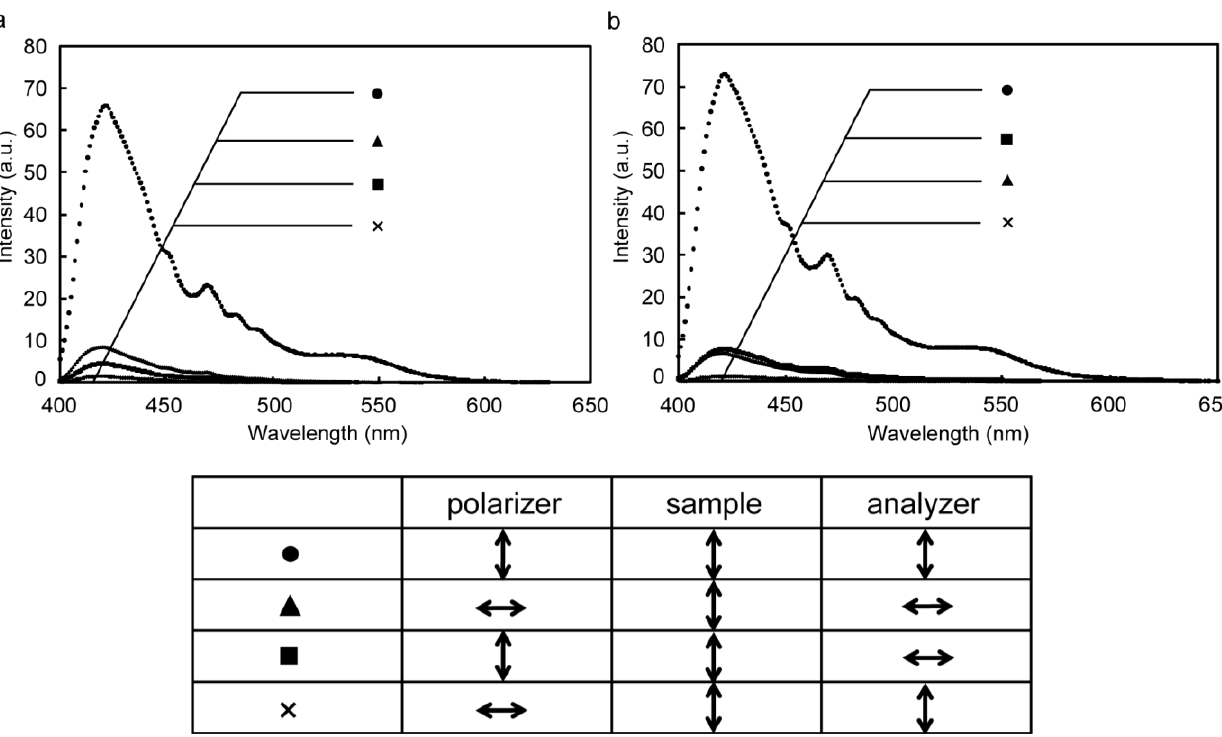
Figure 7. Photoluminescence spectra of Poly(3,4-BAHBA -co- 4HCA) orientation films with the 4HCA compositions of ( a ) 75 mol% and ( b ) 100 mol% under a polarizer and analyzer irradiated at 374 nm with excited light. The table at the bottom shows direction of the polarizer, sample and